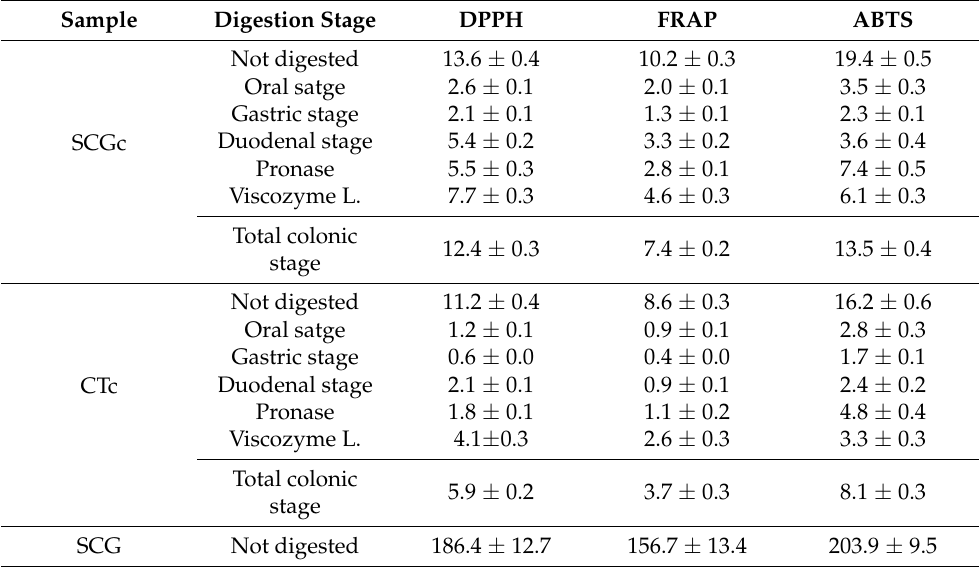
Table 4. Antioxidant activity in not-digested samples and during the simulated gastrointestinal digestion, evaluated by DPPH, FRAP, and ABTS